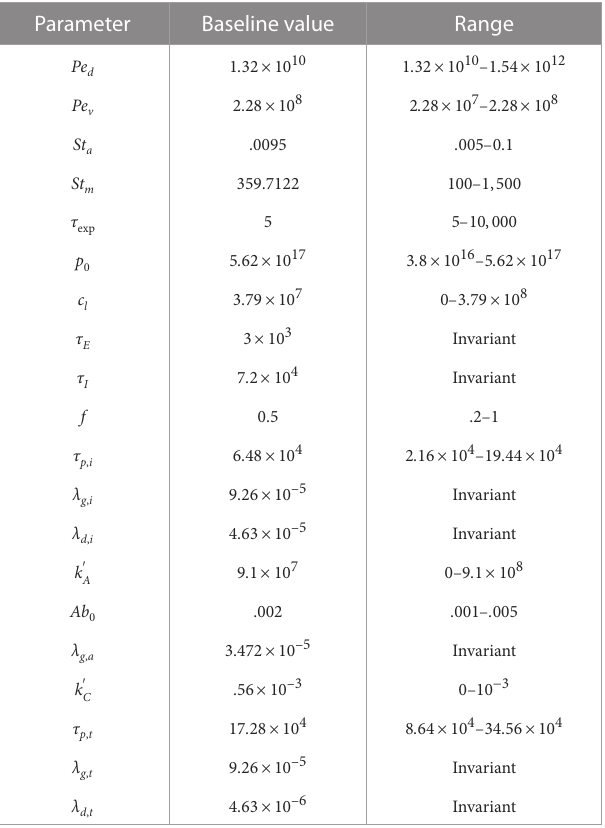
TABLE1 Baselinevaluesofvariousdimensionlessparametersandtheir